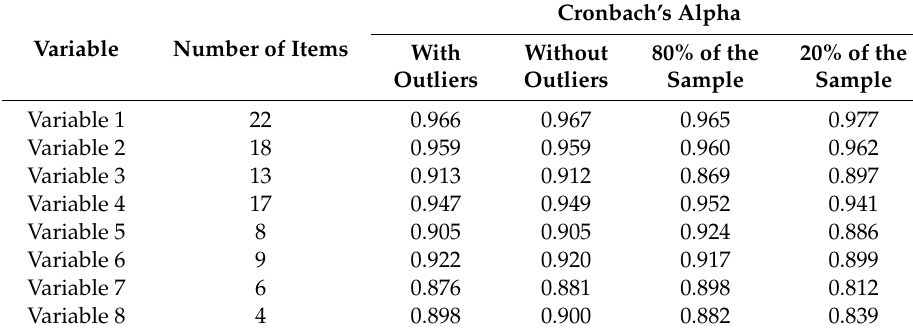
Table 12. Cronbach’s alpha.